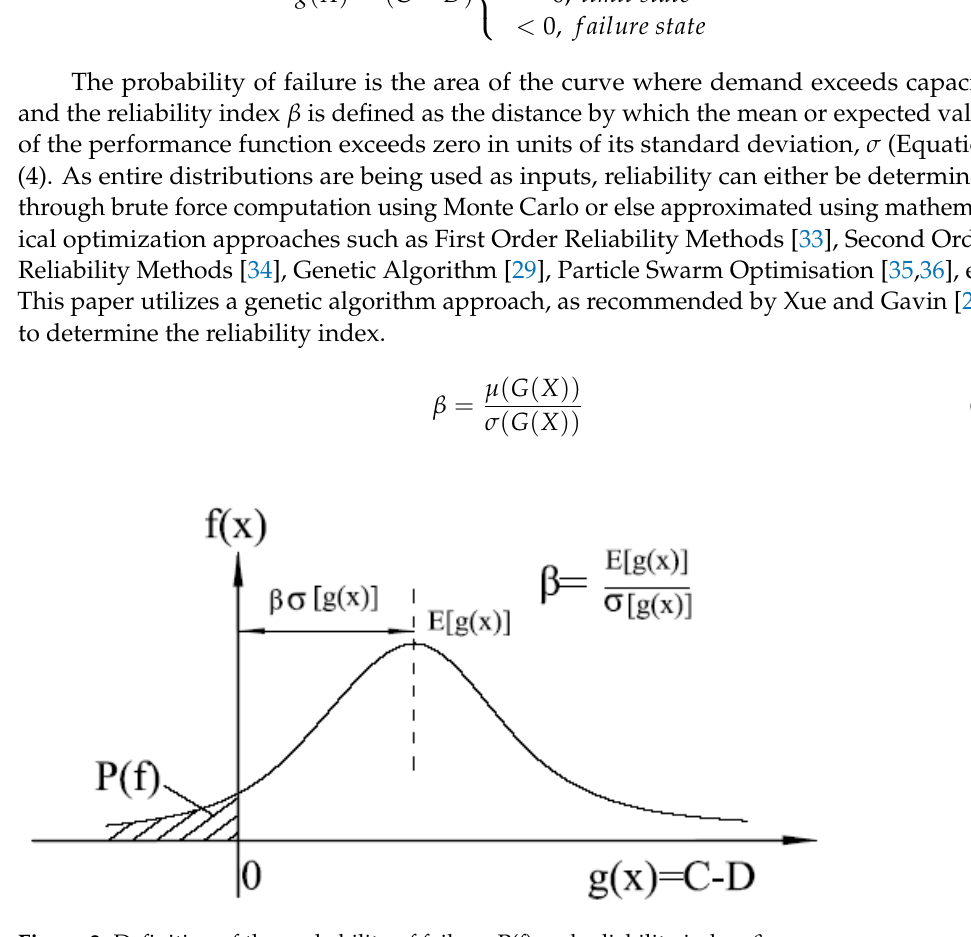
Figure 3. Definition of the probability of failure, P(f) and reliability index, β .